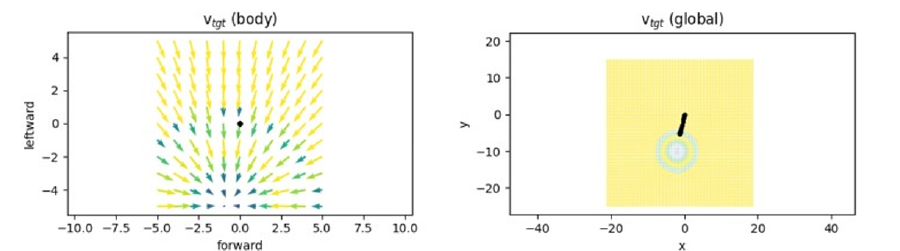
Figure 4. The target velocity map. Table 1. State space.